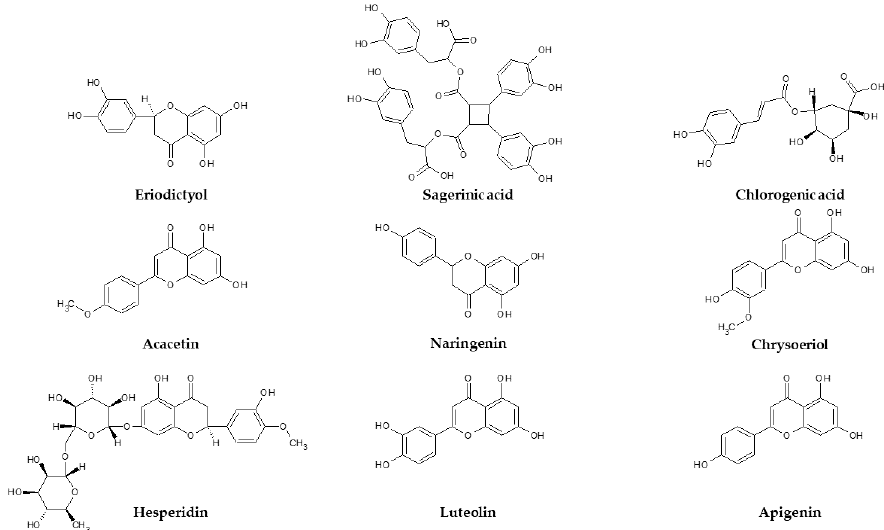
Figure 9. Structure of eriodictyol, acacetin, hesperidin, sagerinic acid, naringenin, luteolin, chloro- genic acid, chrysoeriol and apigenin.